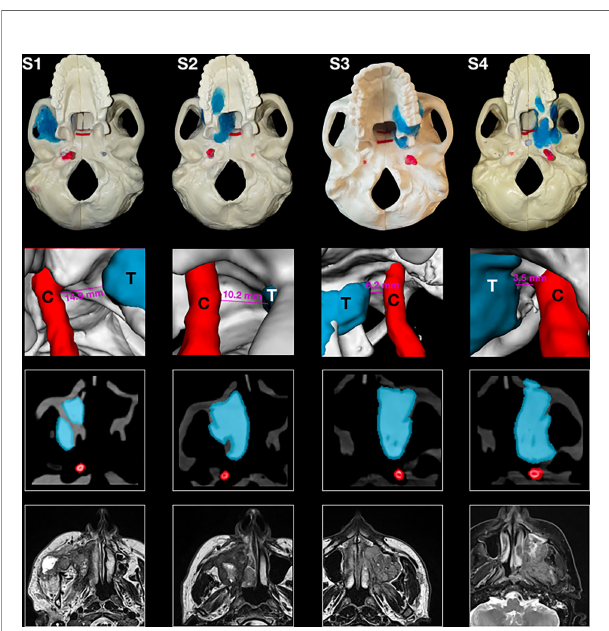
FIGURE 1 | Panel with four phantoms, as seen from an inferior perspective ( superior row ); 3D rendering of the tumor and the carotid alongside the tumor – carotid distance for each model ( second row ); and appearance of tumors at the computed tomography imaging alongside contouring of the tumor and the carotid ( third row ); and preoperative magnetic resonance imaging (MRI) of four actual cases of maxillary cancers (inferior row